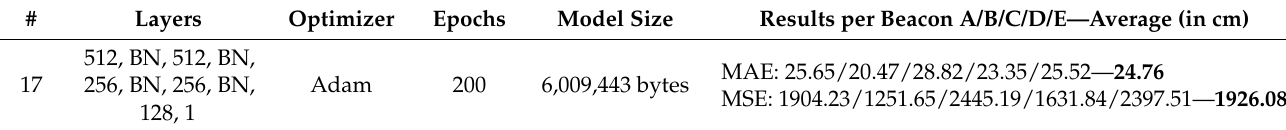
Table 7. Experiment No. 17 parameters and results.